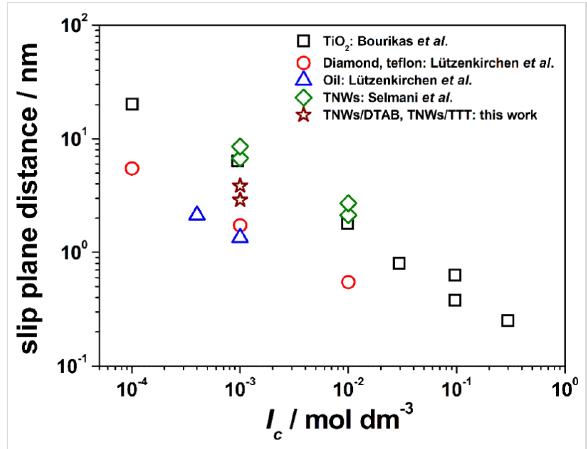
Figure 7: Best fit slip plane distances as a function of ionic strength. The data are taken from the literature. TiO 2 from Bourikas et al. [58] (black squares), diamond, Teflon (red circles) and oil (blue triangles) are taken from Lützenkirchen et al. [59], TiO 2 nanowires from Selmani et al. [48] (green diamonds), and data determined in the frame of the current investigation (brown stars) are